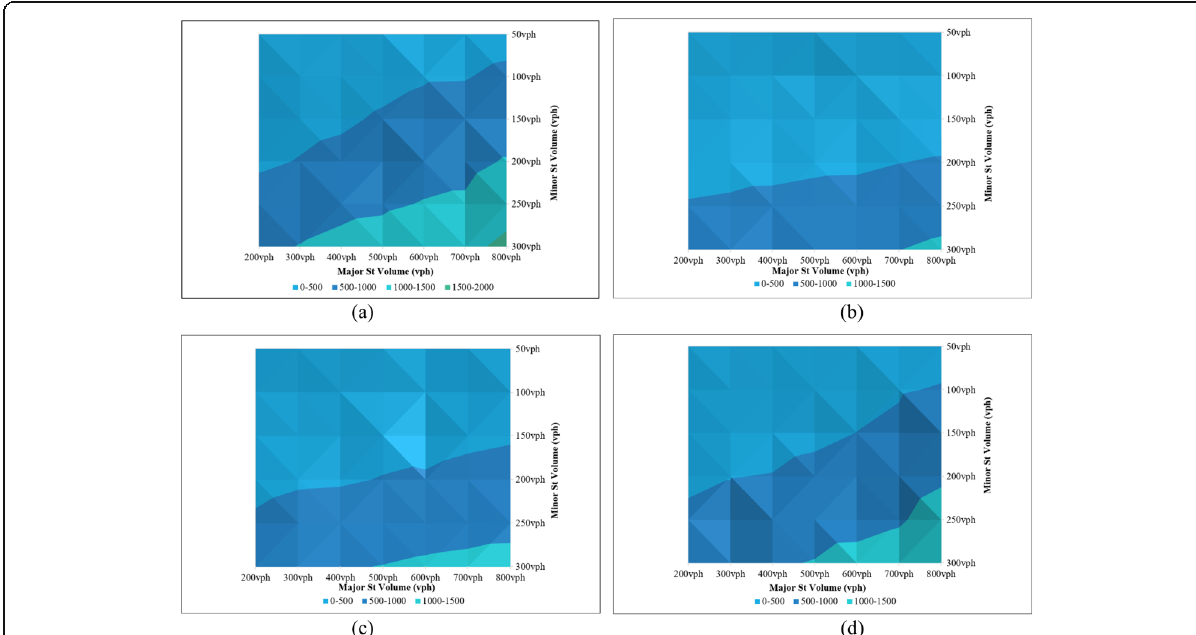
Fig. 8 Simulated Number of Conflicts at Pyramid Way under Various Demand Scenarios: a Free Signal Operation; b 100-s Coordination Plan; c 150 s-Coordination Plan; d 200-s Coordination